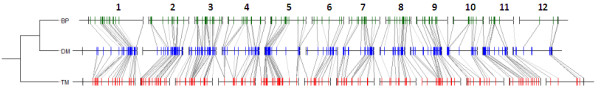
Comparative map of the potato genetic map (BP: integrated map of BCT, PD and PCC1), the potato genome (DM) and the tomato genome (TM). The potato genetic map was scaled to the size of the corresponding DM pseudomolecule setting the last COS marker of each linkage group equal to the size of the pseudomolecule. Likewise, the tomato genetic map was scaled using the pseudomolecule size of the corresponding tomato physical map. Lines are drawn between corresponding COSII markers. A generic tree is drawn to the left hand grouping visually the two potato maps versus the tomato map. Linkage groups and pseudomolecules are drawn sequentially from left to right as indicated by the numbers.